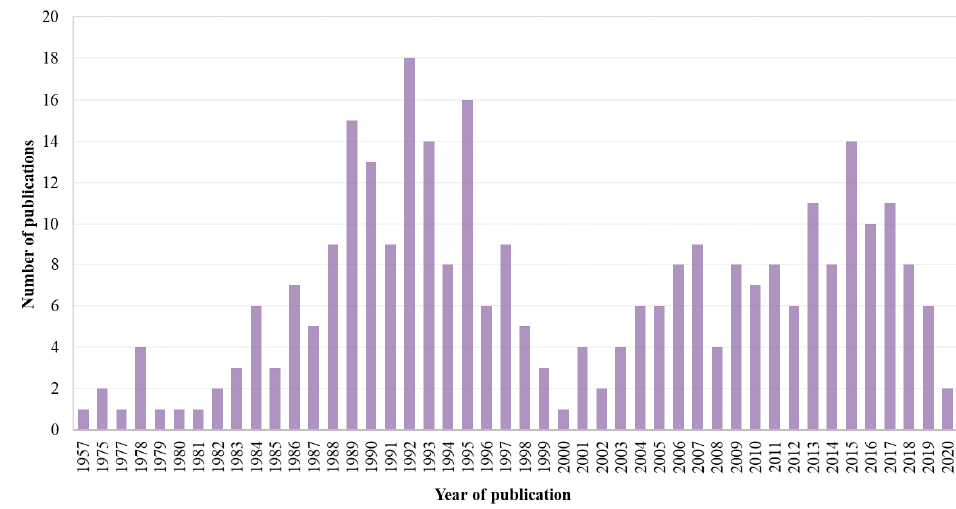
Figure 34. Scientific publications per year in the period 1957–2020.